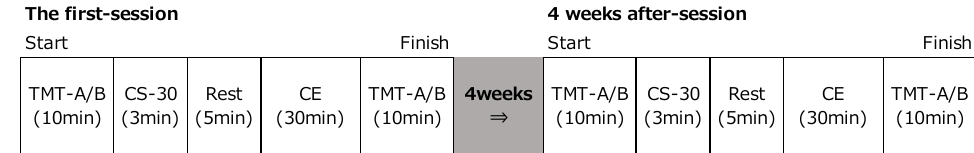
Figure 2. Experimental design (Study 2). CS-30: Exercise task using a chair, CE: Co-kara exercise.